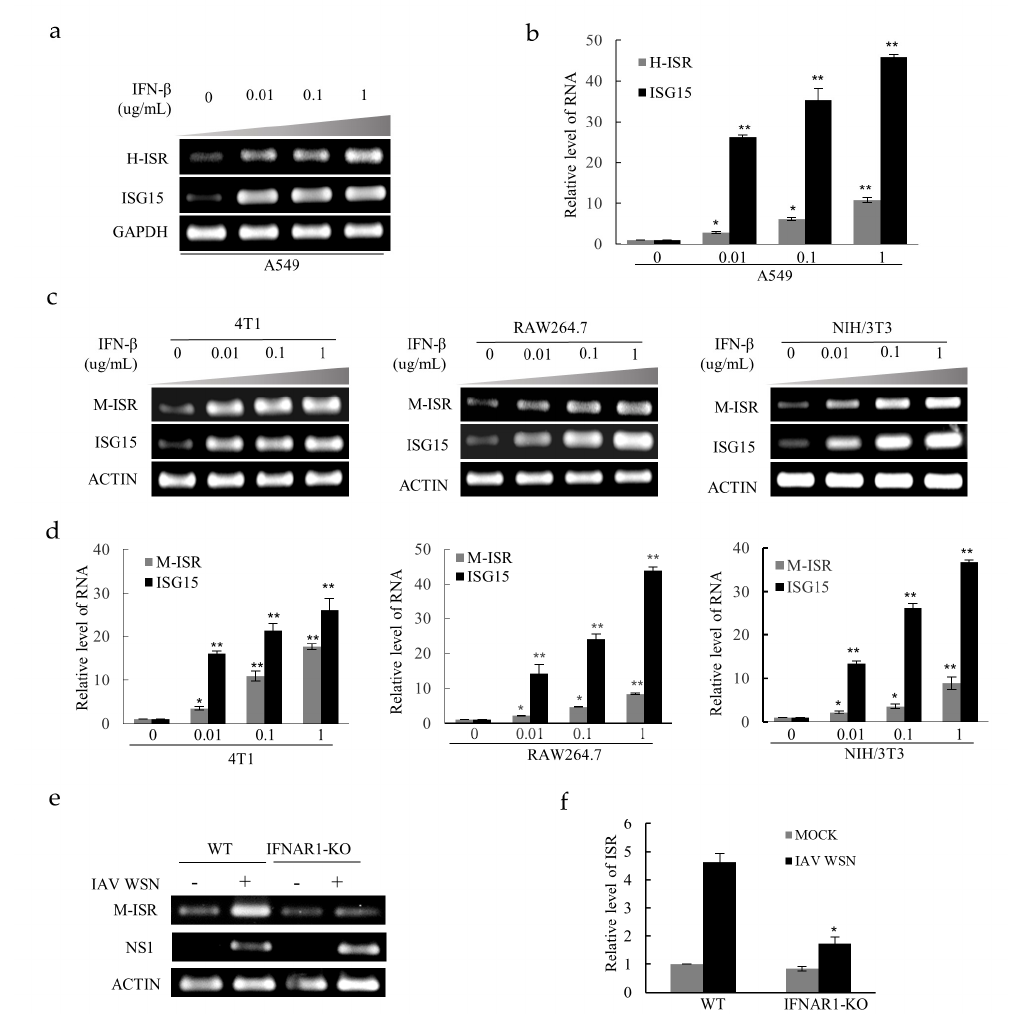
Figure 5. LncRNA ISR expression is induced by IFN- β . ( a , b ) A549 cells were treated with IFN- β at the indicated concentrations for 3 h. After treatment, total RNA was extracted for RT-PCR ( a ) and qRT-PCR ( b ) to detect lncRNA ISR expression. Data are represented as mean ± S.D. * p < 0.05; ** p < 0.01; ( c , d ) Mouse cells (4T1 cells, RAW264.7 cells, NIH/3T3 cells) were treated with IFN- β at indicated concentrations for 3 h. RT-PCR ( c ) and qRT-PCR ( d ) was performed to determine the lncRNA ISR